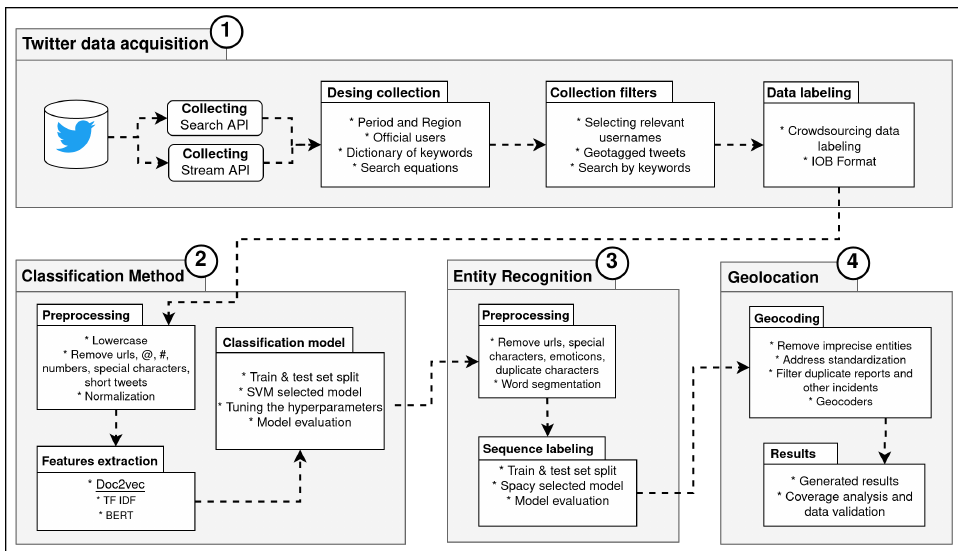
Figure 1. Proposed methodology for automatic detection of traffic accidents on Twitter ( 1 ) Twitter data acquisition; ( 2 ) Classification method to automatically filter tweets on accident reports; ( 3 ) Extraction of location and time entities from the traffic accident report; ( 4 ) and geolocation of